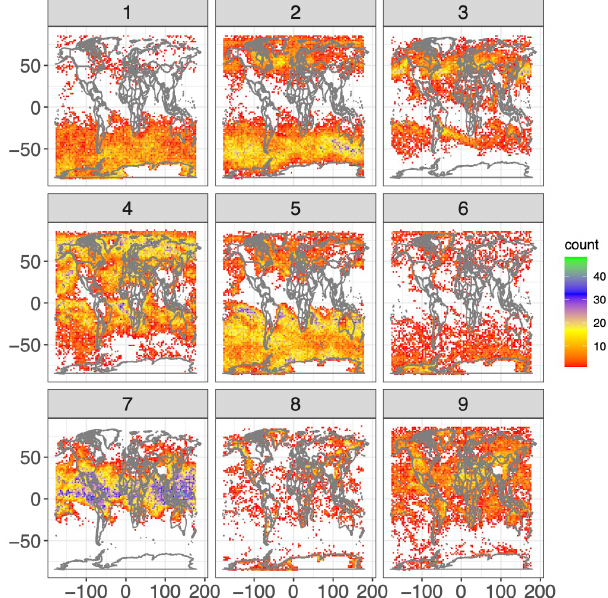
Figure 11. Geographic distribution by cluster of AMV retrieval lo- cations in the testing dataset. Each sub-panel represents one cluster.